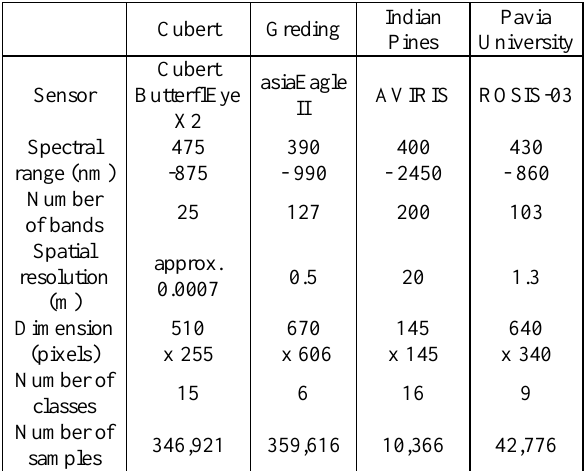
Table 2. Overview of the used datasets (Gross et al.,